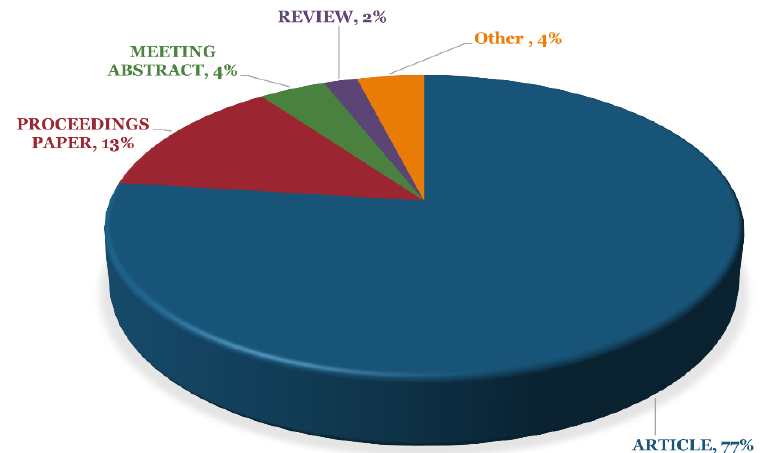
Figure 3. The obtained results demonstrating the types of published scientific documents on toxicity analysis on industrial wastewater during the adopted period (1950–2020) gathered from WoS.